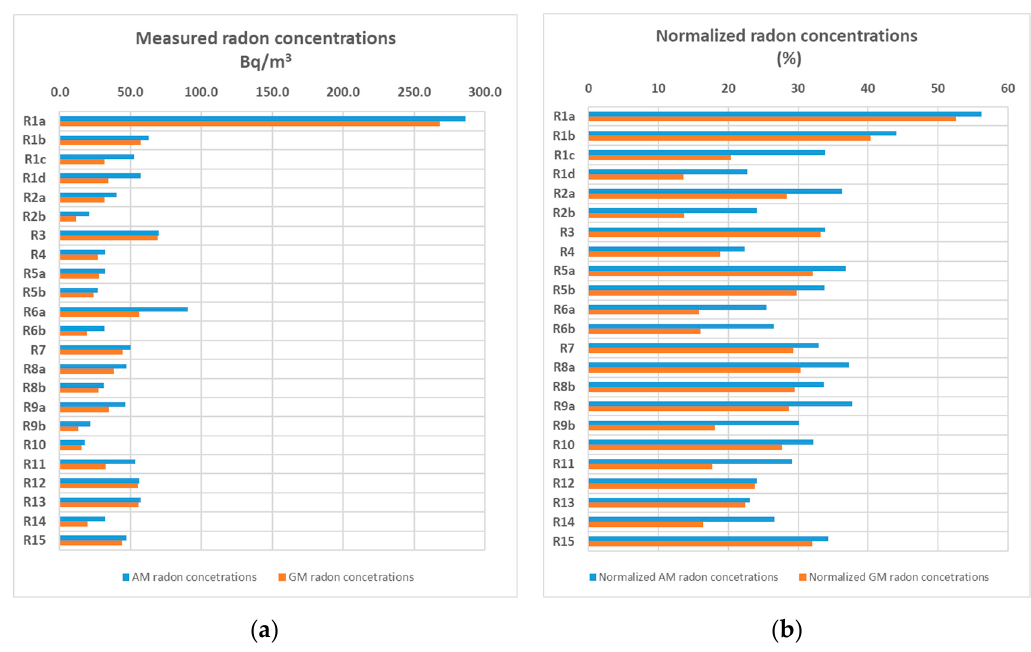
Figure 5. ( a ) Radon AM and GM concentrations. ( b ) Normalized AM and GM radon concentrations.